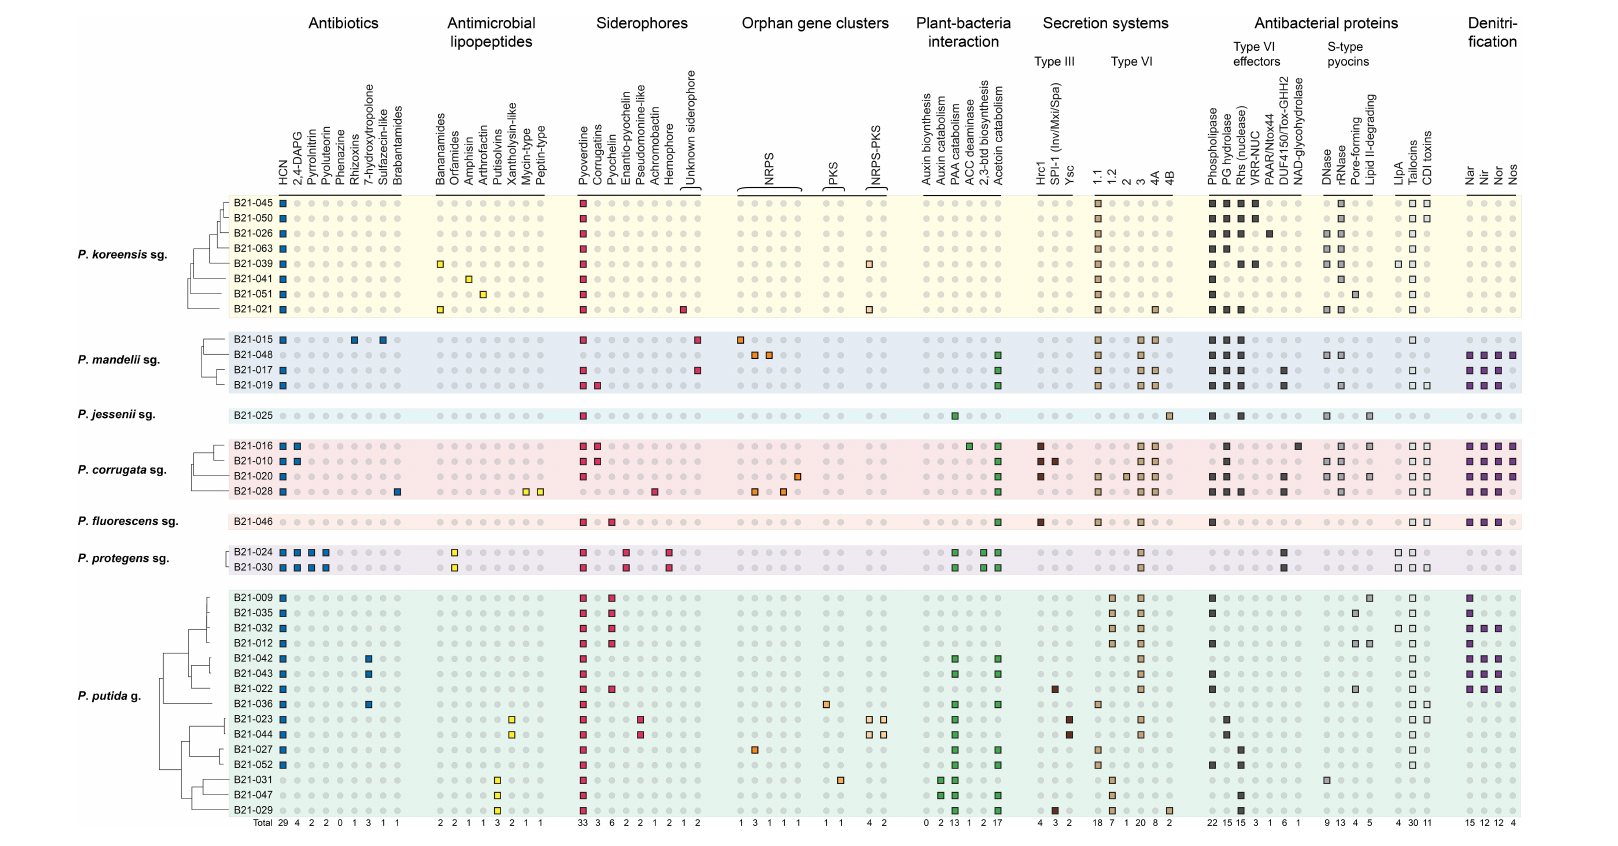
FIGURE3 Distribution of diverse genes and clusters involved in plant-bacteria interactions, microbial competition, and biocontrol in the genomes of the 35 Pseudomonas strains. HCN, hydrogen cyanide; 2,4-DAPG, 2,4-diacetylphloroglucinol; NRPS, non-ribosomal peptide synthase; PKS, polyketide synthase; PAA, phenylacetic acid; ACC, 1-aminocyclopropane-1-carboxylate; 2,3-btd,